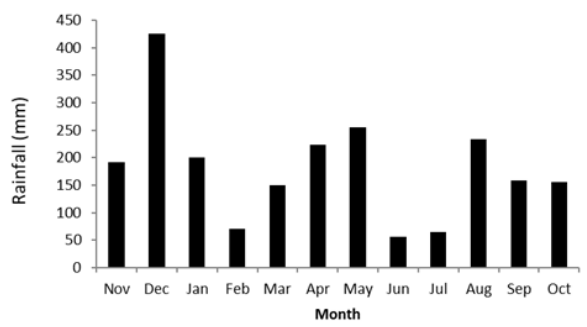
Figure 2. Rainfall distribution (mm) from November 2016 to October 2017, recorded at the 1 st Division (Block C.6) Teluk Panji Plantation, approximately 2 km from the study site.